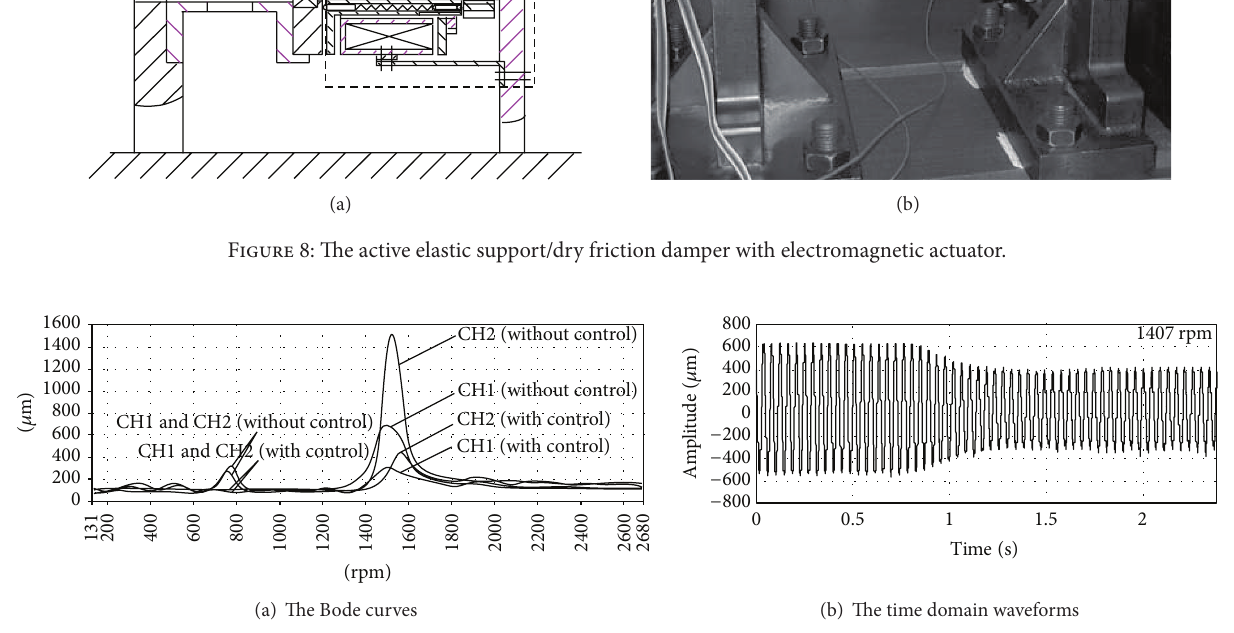
Figure 9: The Experimental result of the rotor with active elastic support/dry friction damper with electromagnetic